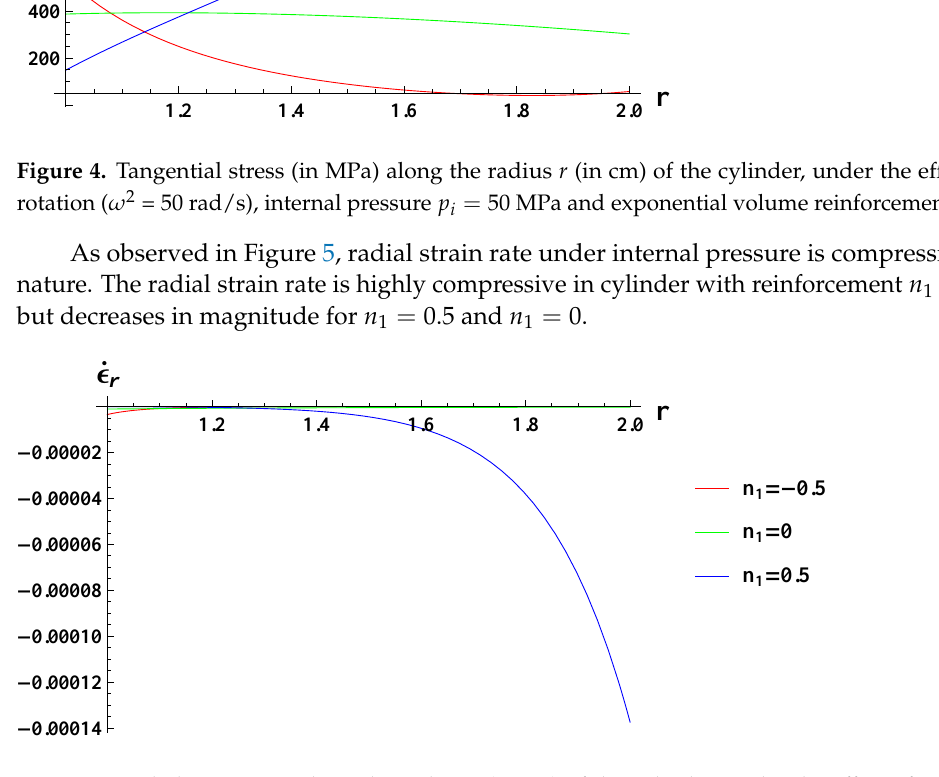
Figure 5. Radial strain rate along the radius r (in cm) of the cylinder, under the effect of rotation ( ω 2 = 50 rad/s), internal pressure p i = 50 MPa and exponential volume reinforcement. Figure 6 presents tangential strain rate for a cylinder under internal pressure and rotation. It is seen that the tangential strain rate is positive for all the cases of